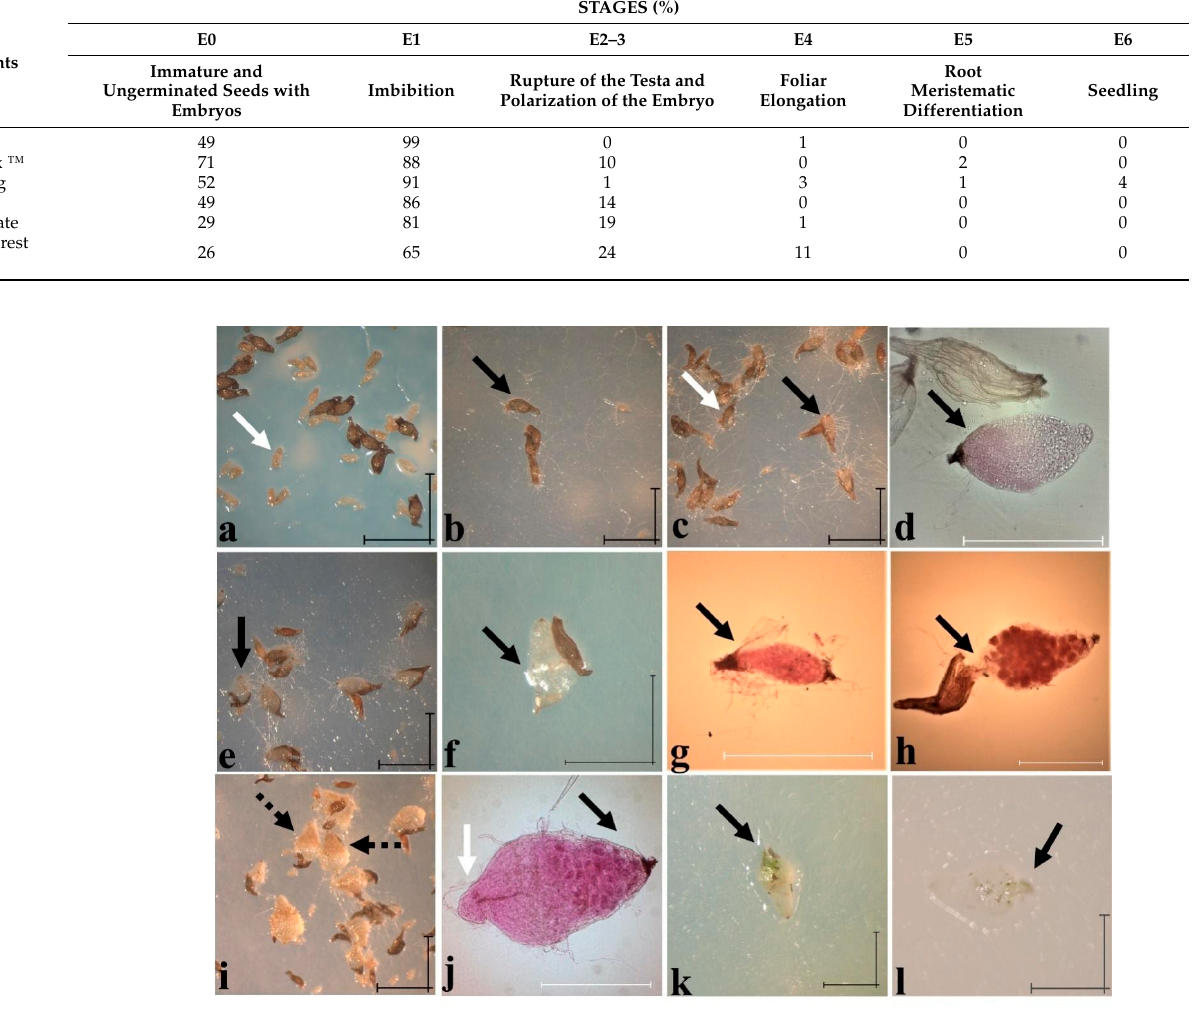
Figure 11. Symbiotic in vitro germination of Cypripedium irapeanum with two Epulorhiza spp. ( Tulasnella spp.) isolates obtained from an oak forest in Mexico State and a tropical deciduous forest in Veracruz State with seeds from Puebla State. ( a ) Seed imbibition (stage 1) before fungal contact at 2 days after sowing (das) (white arrow shows immature and ungerminated seeds with embryos) with a Mexico State isolate. ( b ) Mycorrhizal contact during seed imbibition at 12 das with the Veracruz isolate. ( c ) Symbiotic protocorms surrounded by mycelium (not rhizoids) at stages 2 (white arrow) and 3 developing rhizoids (black arrow) at 12 das with a Veracruz isolate. ( d ) Protocorm out of testa at 12 das stained with acid fuchsine showing pelotons at the micropillar seed region (black arrow) and hyphae growing in medium. ( e , f ) Symbiotic protocorms at stages 3 ( e ) and 4 ( f ) at 22 and 54 das, respectively, with the Veracruz isolate showing early vitrification and fungal incompatibility (black arrows). ( g , h ) Histological staining evidence of the fungal incompatibility, where pelotons invade apical meristematic tissue cells (black arrows) at stage 3 ( g ) and stage 4 ( h ), both at 109 das with an isolate from Mexico State. ( i ) Symbiotic protocorms at 187 das showing fungal compatibility that are located in a brownish tissue in the micropylar zone (black dashed arrow) with the Veracruz isolate. ( j ) Histological view of a stained mycorrhized protocorm with dense pink pelotons (black arrow) at the micropylar pole and with intact leaf vascular bundles (white arrow) at 96 das. ( k , l ) Symbiotic mixotrophic protocorms at stage 4 (with two foliar sheets) at 72 and 109 das with the Veracruz isolate. Scale bar = 100 µ m. Photos taken by Mauricio Moreno in